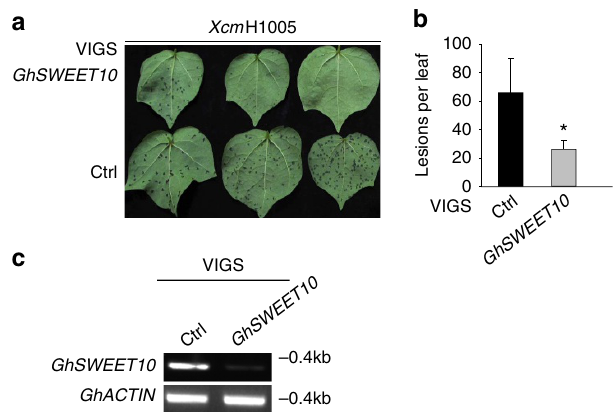
Figure 5 | Silencing of GhSWEET10 in cotton reduces water-soaking caused by Xcm infection. ( a ) Xcm -mediated water-soaking lesion development on cotton plants upon VIGS. Cotyledons from 2-week-old Ac44E plants were syringe-infiltrated with Agrobacterium carrying a VIGS construct to silence GhSWEET10 (VIGS- GhSWEET10 ) or a GFP vector control (VIGS-Ctrl). Three weeks later, plants were vacuum infiltrated with Xcm H1005 at OD 600 ¼ 0.01. Images were taken 2 weeks after inoculation. ( b ) Quantitative analysis of Xcm -mediated water-soaking lesions on cotton plants upon VIGS. Lesions were counted on the second true leaf of each VIGS plant (at least 10 plants were inoculated for each construct in each repeat). The data are shown as mean ± s.e. ( n ¼ 10). The asterisk indicates a significant difference with a Student’s t -test ( P o 0.05) when compared with the control. ( c ) RT–PCR analysis of GhSWEET10 expression in cotton plants upon VIGS. VIGS assays were done similarly as in a and 3 weeks later, the second true leaf was collected for RT–PCR analysis before Xcm inoculation. GhACTIN was used as an internal control. The above experiments were repeated three times with similar H1005 induced relatively weak water-soaking on G. arboreum compared to G. hirsutum , likely due to G. arboreum carrying some strain-specific resistance as noted previously 44 . Taken together, these results indicate that Avrb6 can directly target SWEET10 in both the A and D genomes to contribute to the development of BBC.